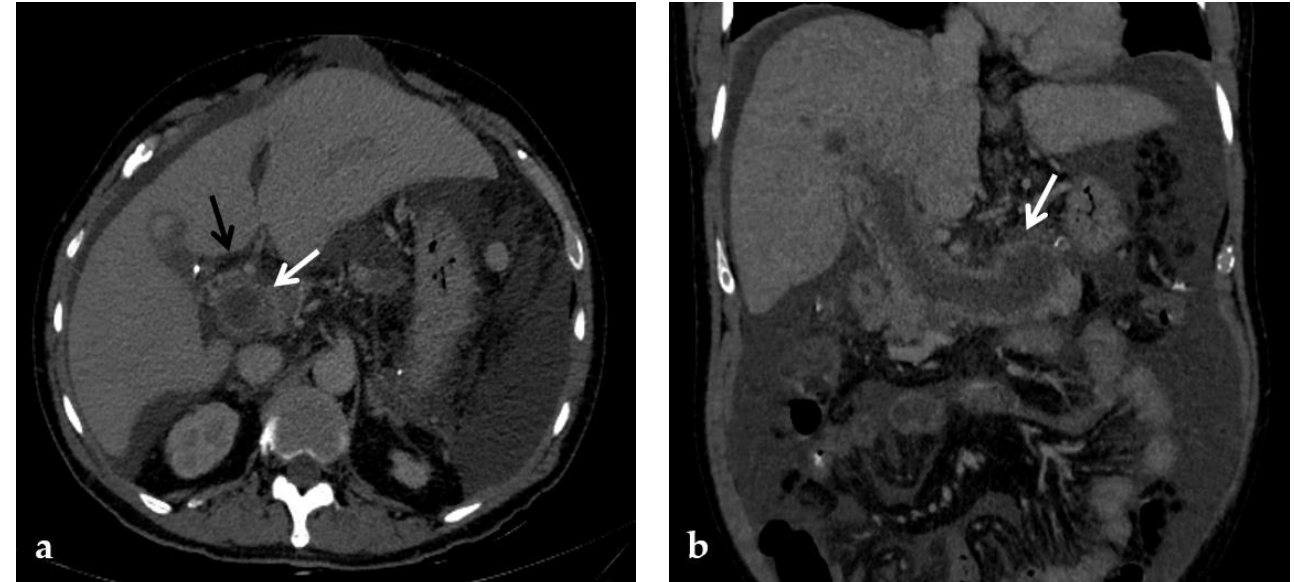
Figure 4. CT images of portal vein thrombosis in a 62-year-old male affected by myelofibrosis, who presented with intense abdominal pain. ( a ) Portal phase axial CT image shows a lack of luminal enhancement in the porta hepatis, increased portal vein caliber with enhancing walls, and a low- attenuating thrombus within the lumen, consistent with acute portal vein thrombosis (white arrow). Multiple collateral vessels forming a cavernoma are seen at the hepatic hilum (black arrow). ( b ) Portal phase coronal CT image better shows the extension of portal vein thrombosis, also involving the splenic vein (arrow).